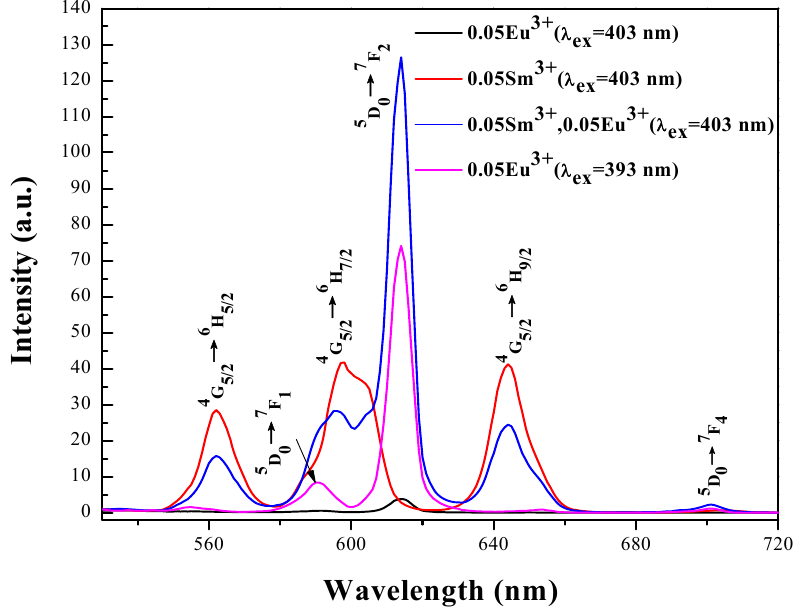
Figure 5. Emission spectra of LL 0.95 M:0.05Eu 3+ , LL 0.95 M:0.05Sm 3+ and LL 0.90 M:0.05Sm 3+ , 0.05Eu 3+ ( λ ex = 403 nm) compared with the emission spectra of LL 0.95 M:0.05Eu 3+ ( λ ex = 393 nm). The emission spectra of LL 0.95 − y M:0.05Sm 3+ , y Eu 3+ ( y = 0, 0.01, 0.03, 0.05, 0.08, 0.12) under 403 nm excitation are shown in Figure 6. With the Eu 3+ concentration increase, the luminescence intensity of Sm 3+ gradually decreased while the 5 D 0 → 7 F 2 (614 nm) emission of Eu 3+ is continuously enhanced.